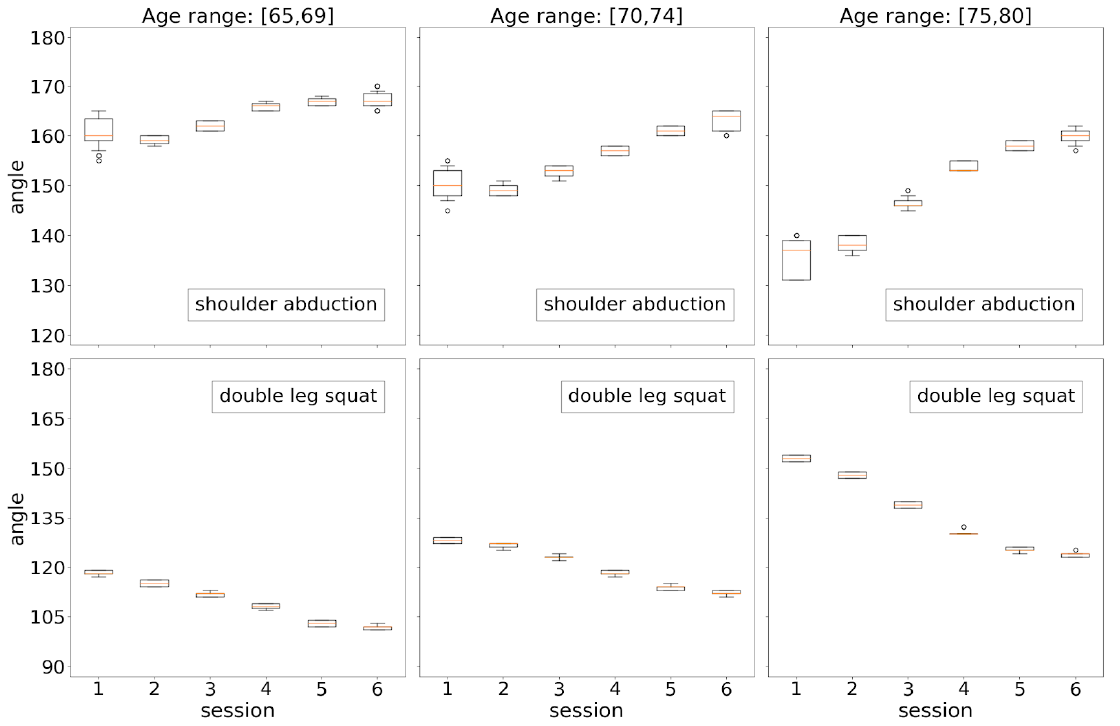
Figure 19. Distributions of exercise results by session from an age perspective.